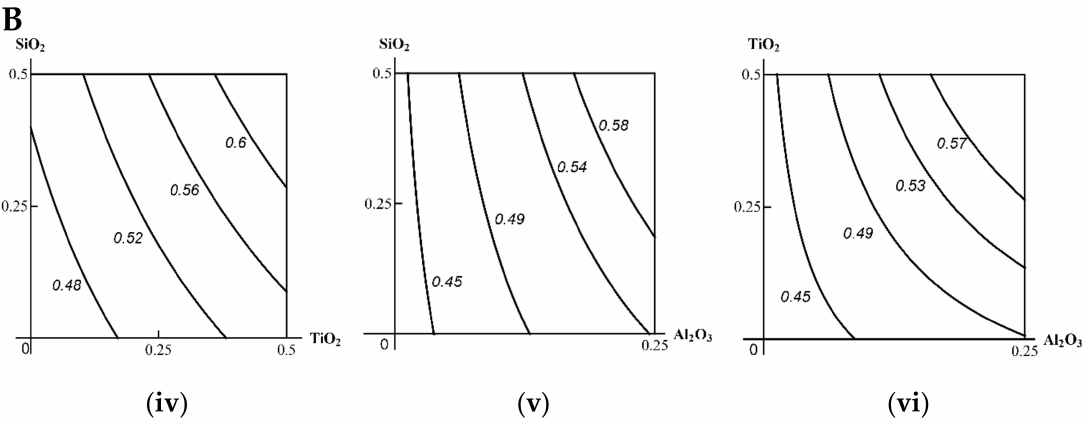
Figure 8. Isobolograms for the binary combined genotoxicity of nanoparticles assessed by the increase in the fragmentation factor of nucleated blood cells as follows: ( A ) in the absence of a third agent under exposure to: ( i ) SiO 2 + TiO 2 (antagonism); ( ii ) SiO 2 + Al 2 O 3 (additivity); ( iii ) TiO 2 + Al 2 O 3 (synergism); ( B ) in the presence of a third agent: ( iv ) Al 2 O 3 combined with SiO 2 + TiO 2 (additivity); ( v ) TiO 2 combined with SiO 2 + Al 2 O 3 (a single-factor effect transforming into additivity); ( vi ) SiO 2 combined with Т iO 2 + Al 2 O 3 (synergism). The axes plot the doses of relevant MeO NPs in mg per rat; the numbers on the isoboles denote the dimensionless value of the fragmentation factor.